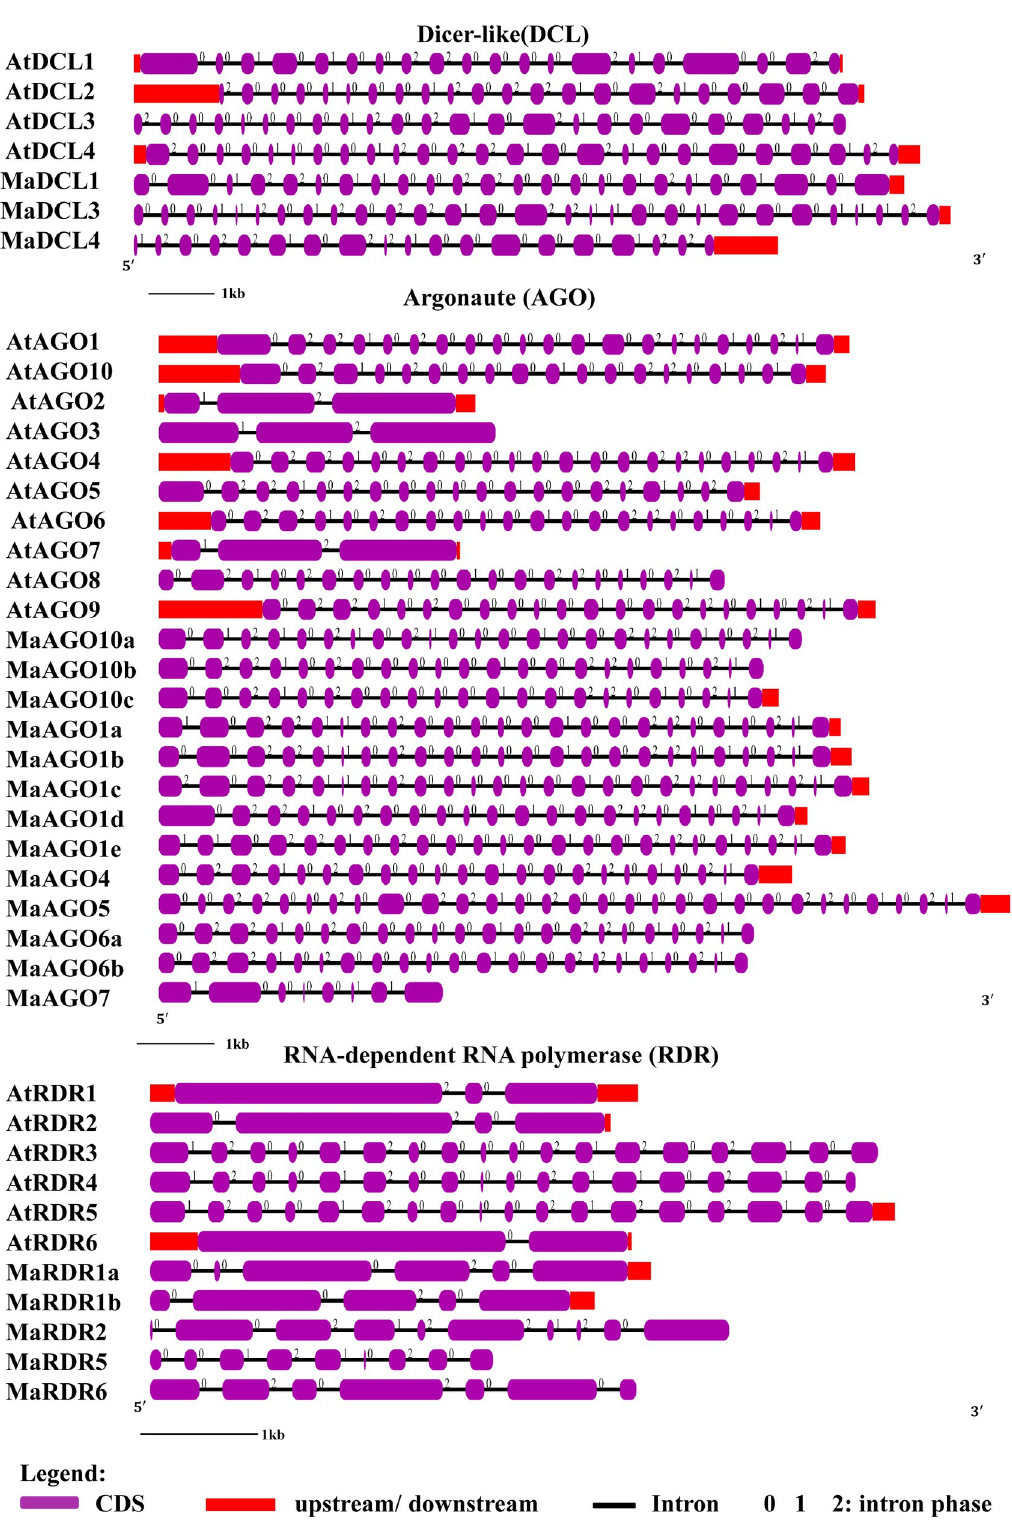
Fig 8. Gene formation of the predicted MaDCL, MaAGO, and MaRDR proteins in M . acuminata with Arabidopsis by using Gene Structure Display Server (GSDS 2.0, http://gsds.cbi.pku.edu.cn/index.php) [76].